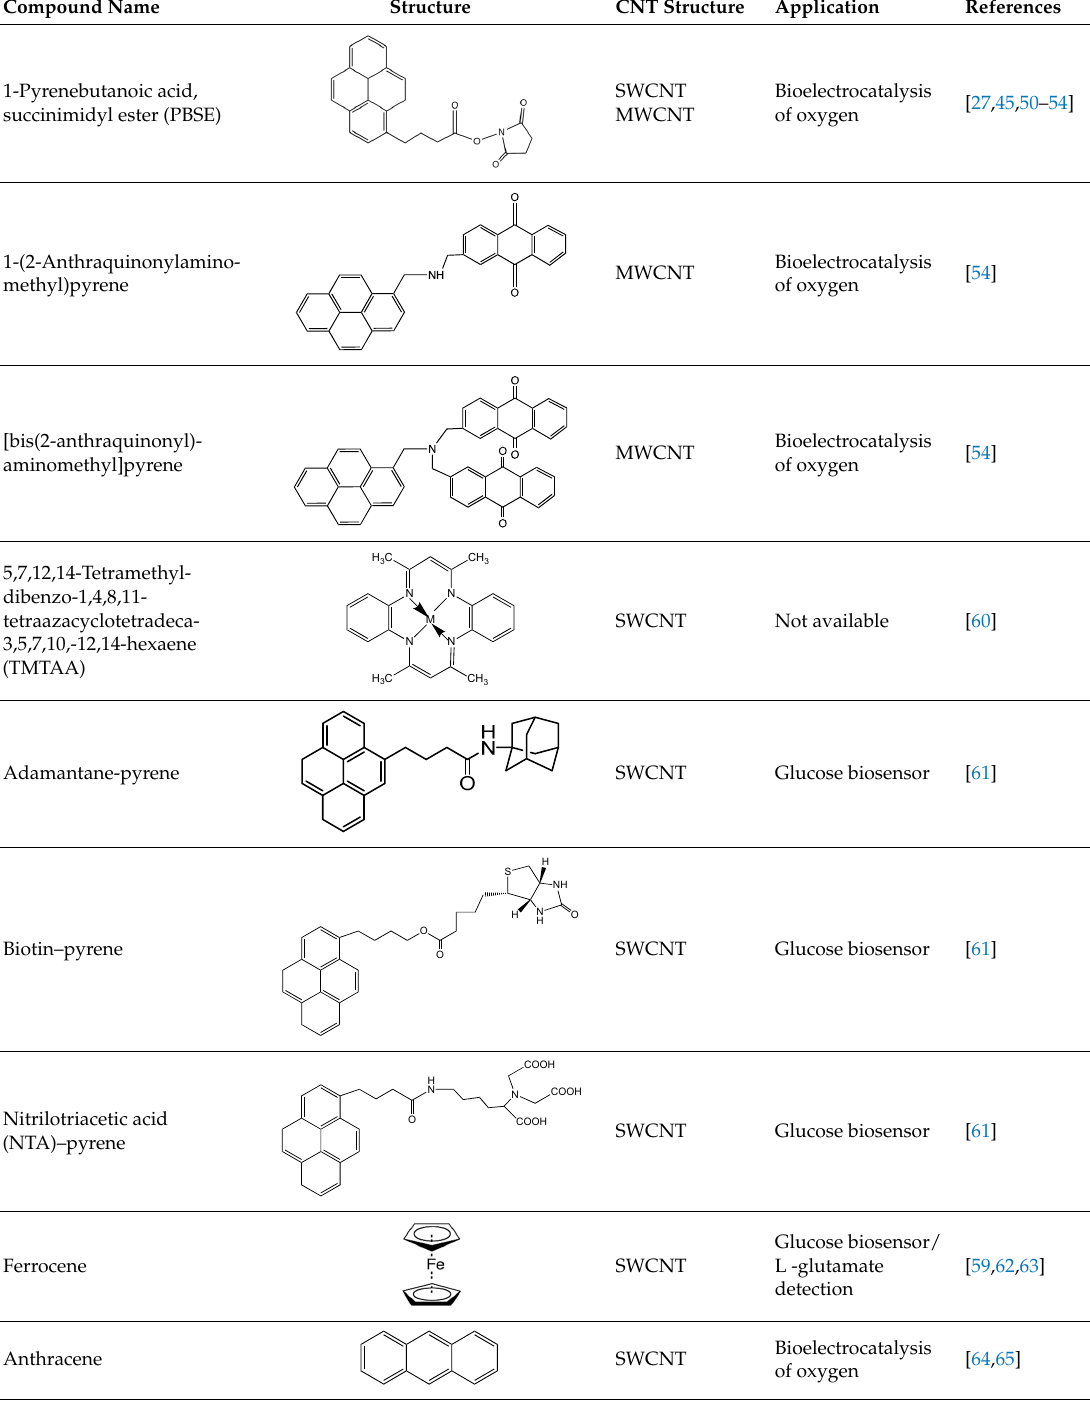
Table 2. List of aromatic compounds used for non-covalent functionalization of carbon nanotubes.